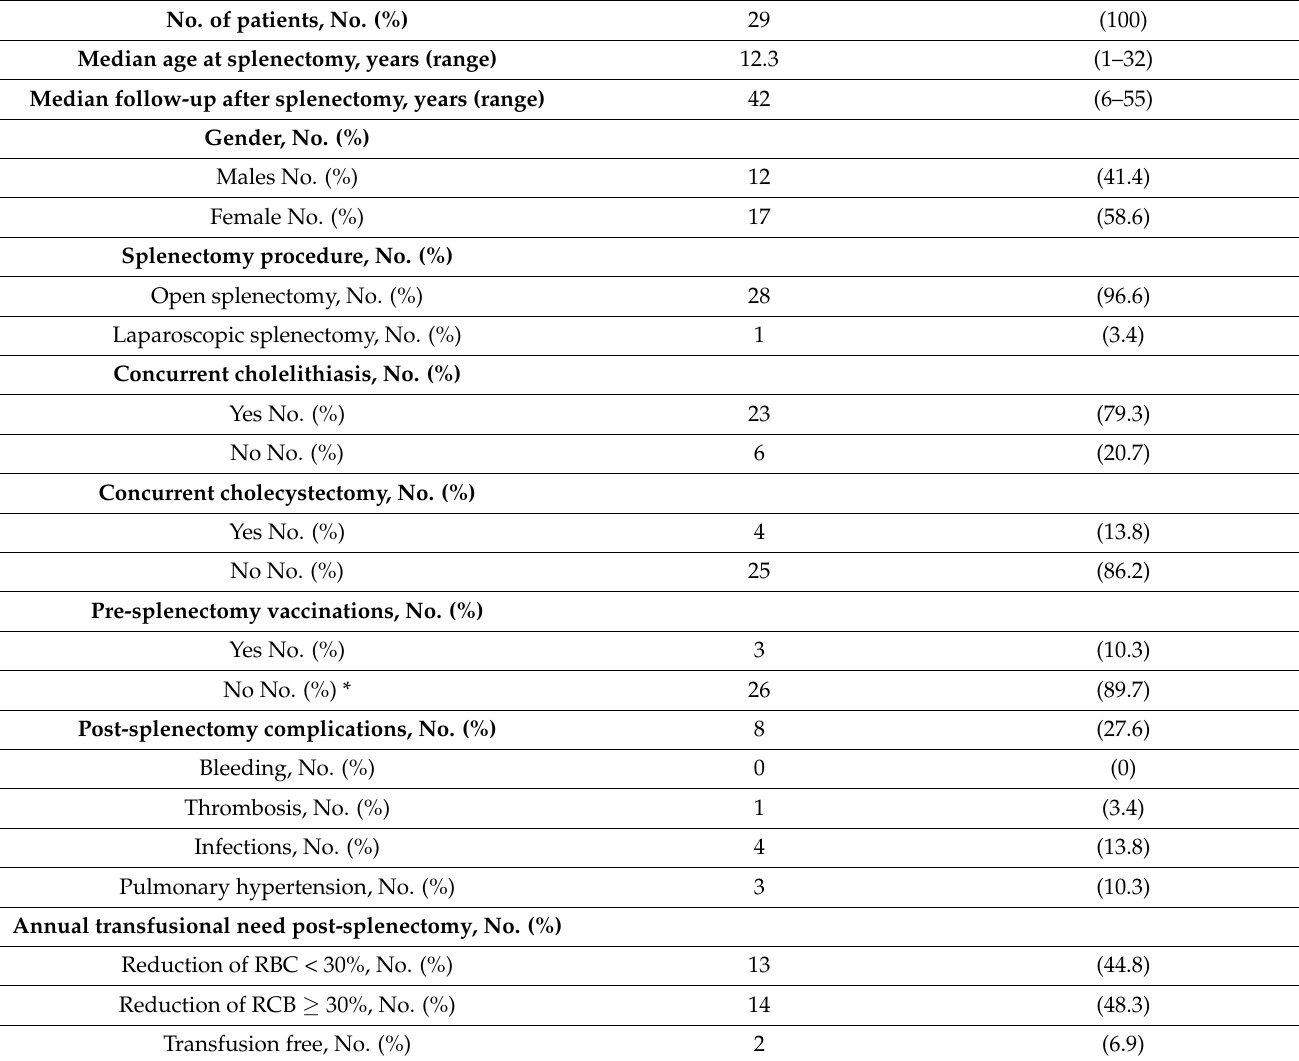
Table 2. Safety and efficacy of splenectomy in patients with β